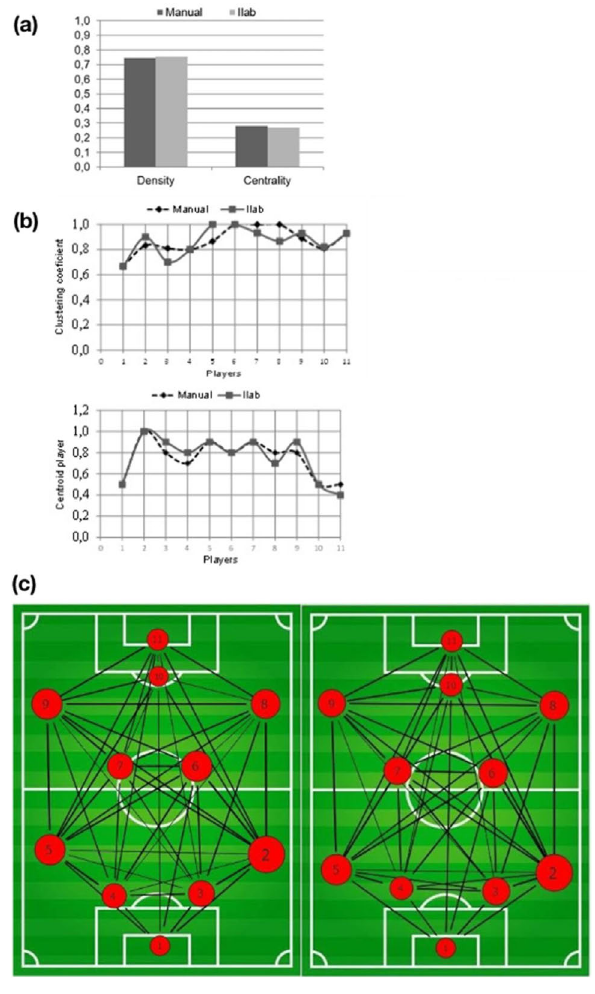
Figure 4 - Description of the analyzed parameters obtained in manual x ILab collection: (a) density and centrality values, (b) centroid player and clustering coefficient values, and (c) description of the network formed by the players. The lines indicate the interactions (passes) performed. The circle indicates each player and its magnitude indicates the partici- pation rate. The figure on the left represents the manual collection and the figure on the right represents ILab collection. Source: